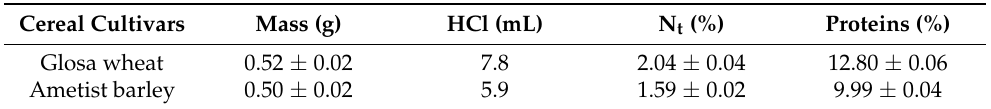
Table 6. Measured contents of the protein concentrations obtained using the Kjeldahl method (means values ± standard deviation).